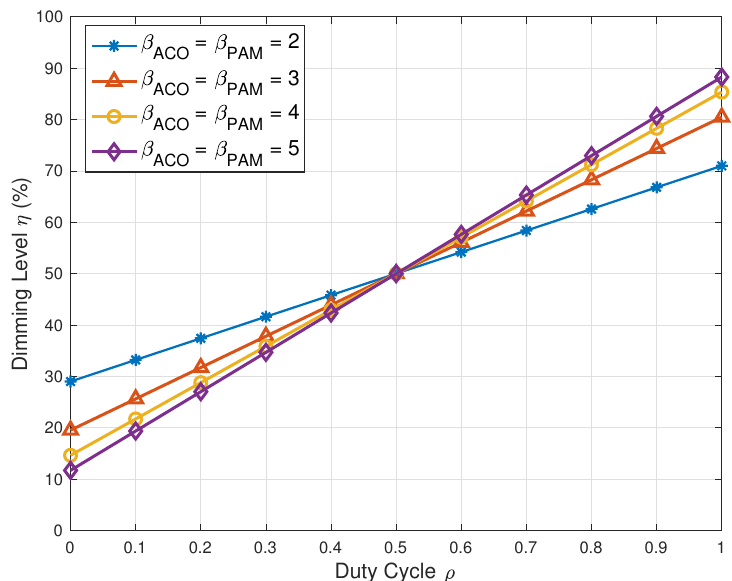
Figure 5. The performance of dimming level η vs duty cycle ρ , with various values of scaling factors.